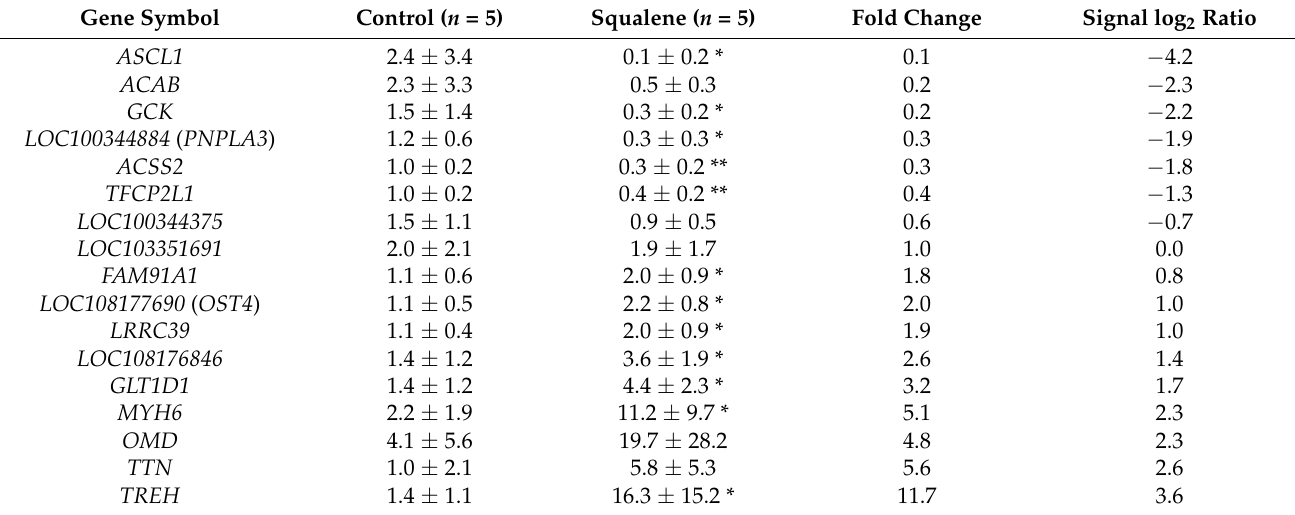
Table 3. Changes in selected hepatic gene expressions of male Oryctolagus cuniculus receiving 0.5 mg/kg squalene/day according to RT-qPCR assay for genes with signal log 2 ratio < − 1.5 or >1.5.